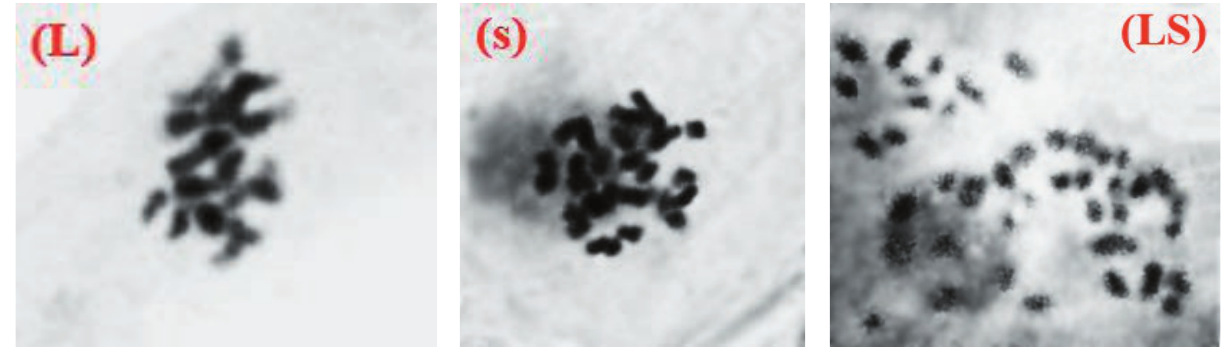
Figure 2. Photomicrographs of well spread mitotic metaphase in the three genotypes of C. bursa pastoris : L: Lobed diploid with 2n=2x=16; S: Simple triploid with 2n=3x=24; LS : Lobed-Simple tetraploid with